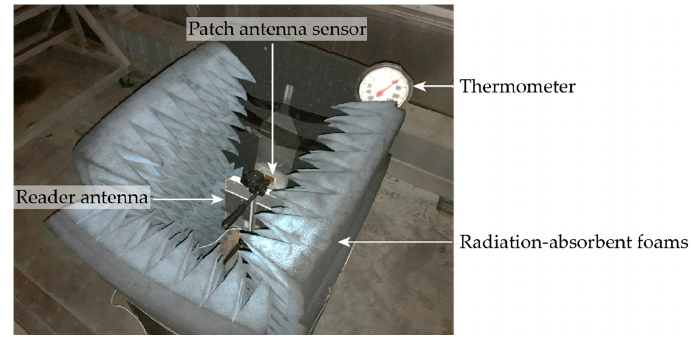
Figure 7. Experimental setup for the temperature chamber test.